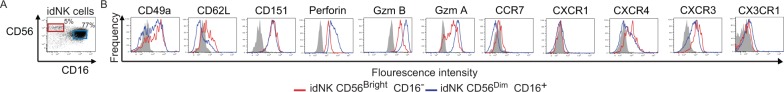
CD56Dim and CD56Bright idNK cells express a panel of markers that differentiate dNK cells from pNK cells with a similar expression pattern.(A) Representative flow cytometry dot plot of idNK cell preparations showing CD56Bright CD16- (red gate) and CD56Dim CD16+ (blue gate) populations. Plots are gated on CD3- cells. (B) Representative histograms showing expression of markers by CD56Bright CD16- (red) and CD56Dim CD16+ (blue) idNK cells. Gray histograms correspond to isotype control staining of CD56Bright CD16- idNK.